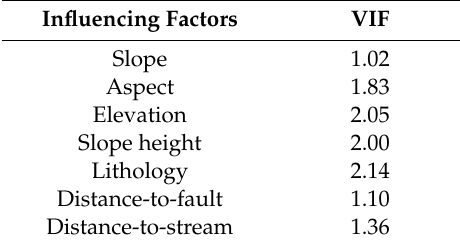
Table 5. Test results of variance inflation factor method of G-GWR